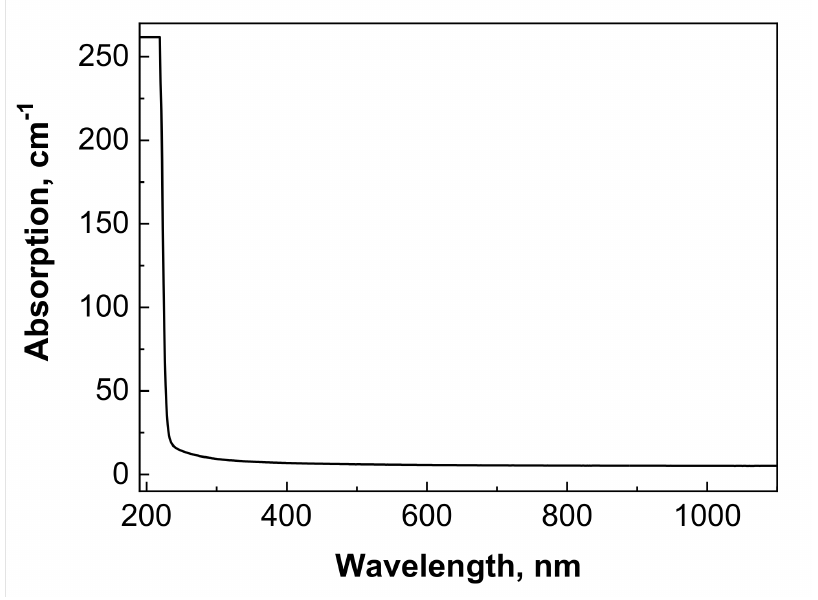
Figure 5. Optical absorption spectrum of Y 1.1 Sc 0.9 O 3 sample with a thickness of 0.5 mm.